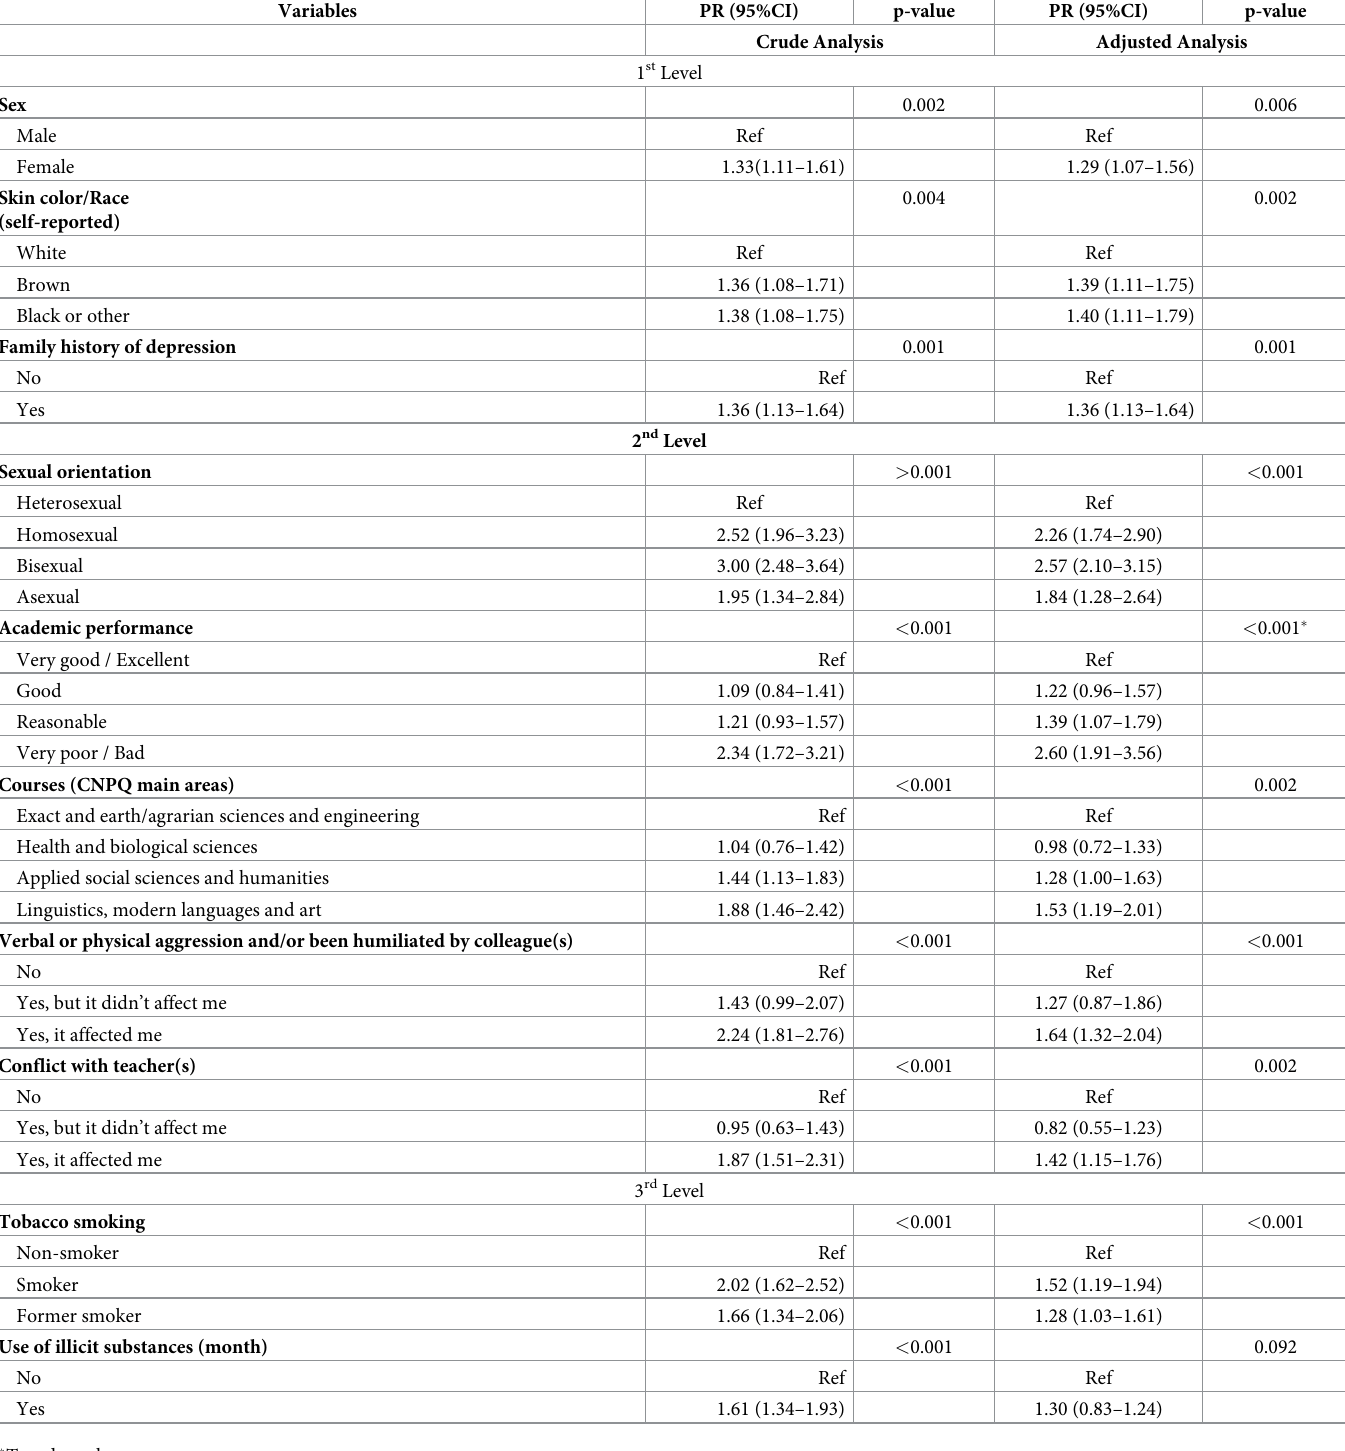
Table 2. Factors associated with externalizing symptoms of major depressive episodes among university students. Pelotas (RS), Brazil,